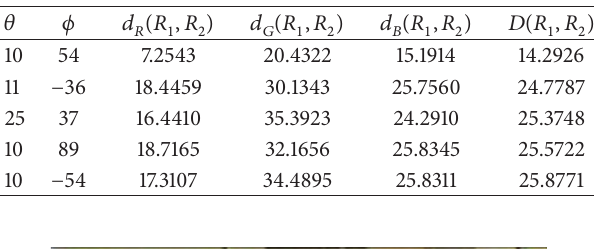
Table 1: Best distances from GEFS and SEFS based method with 𝜌 = 0.007813 for the eraser image dataset obtained from the comparison with the sample image at 𝜃 = 11 ∘ and 𝜙 = 36 ∘ .